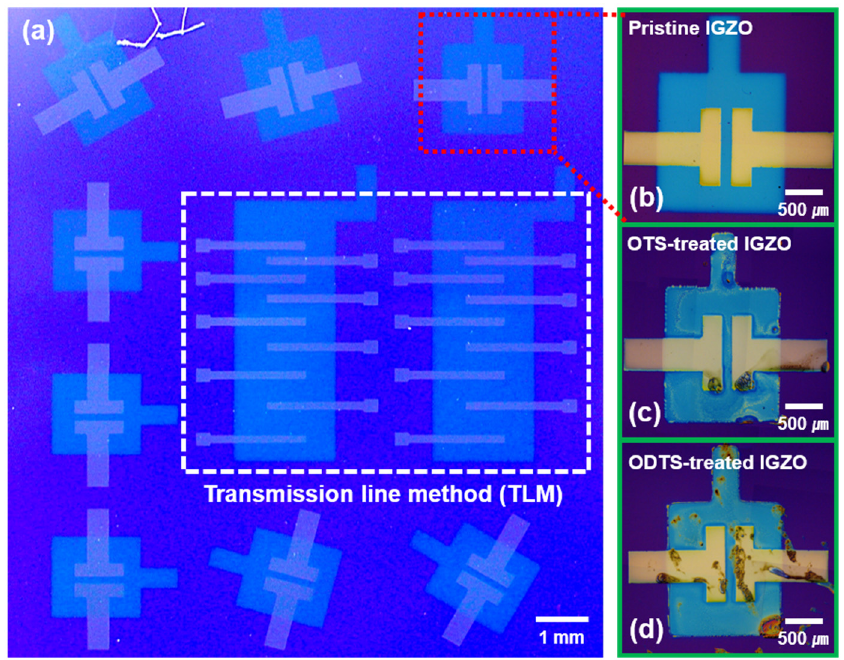
Figure 1. Image of transistor: ( a ) Optical microscopy image of IGZO TFT designed for experiment; ( b ) image of pristine TFT; ( c ) image of IGZO TFT treated with OTS; ( d ) TFT image with ODTS treatment.